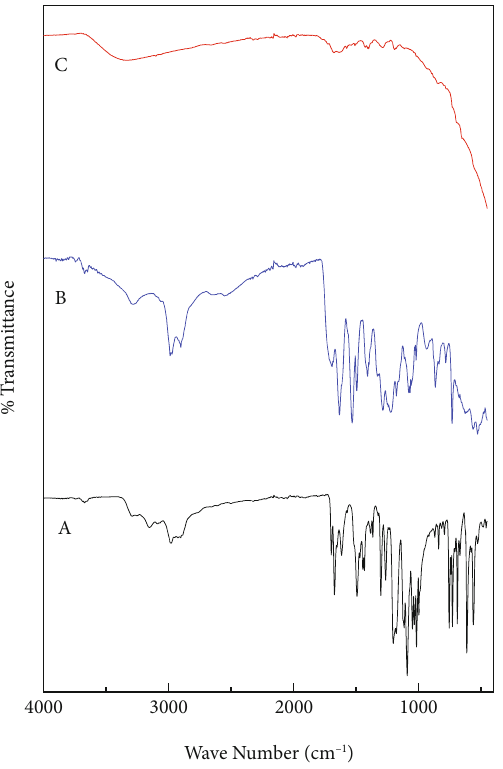
Figure 6: Powder X-ray di ff raction patterns of the (a) Amlodipine, (b) polymer nanoparticles and (c) Amlop-polymer nanocomposite.